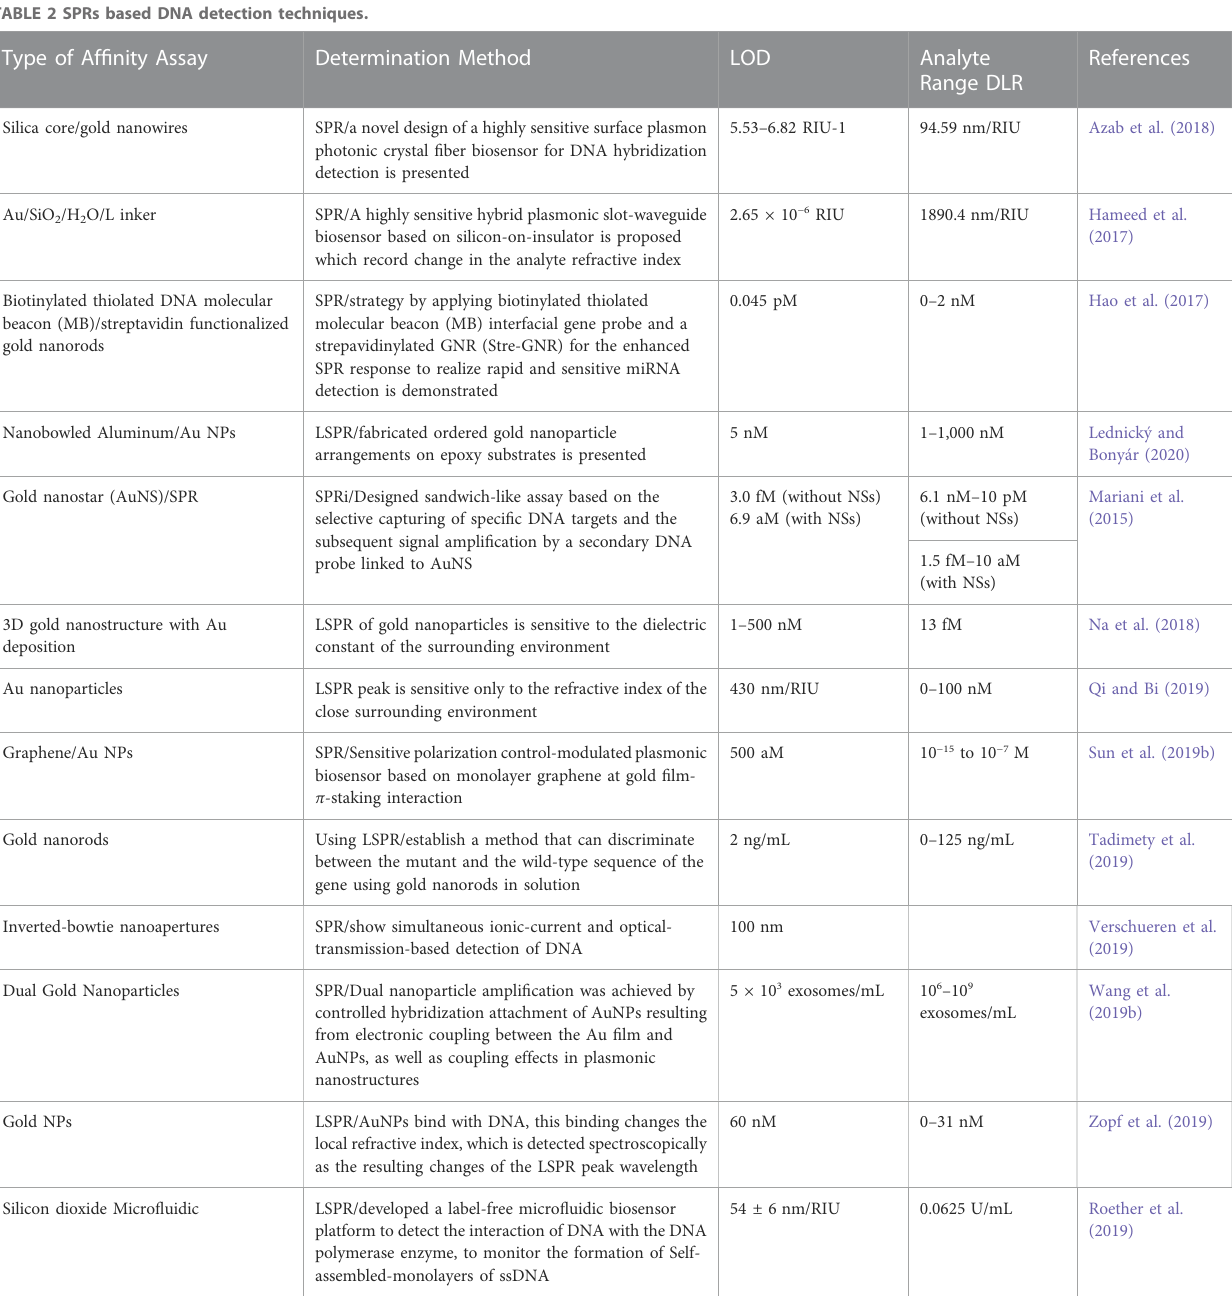
TABLE 2 SPRs based DNA detection